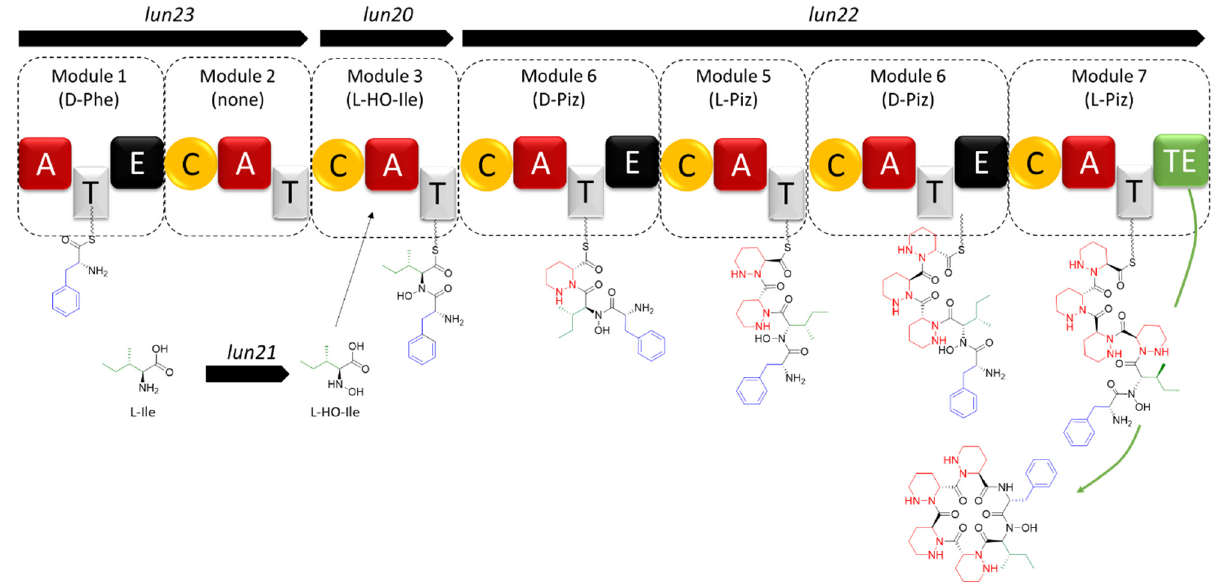
Figure 9. Proposed biosynthetic pathway of lunaemycin A. This model suggests that the Ile will be either N-hydroxylated before activation and recruitment by the A domain (like proposed for the coelichelin pathway) or hydroxylated once activated and tethered on the thiolation domain of Lun20 (like proposed for polyoxypeptin synthesis).